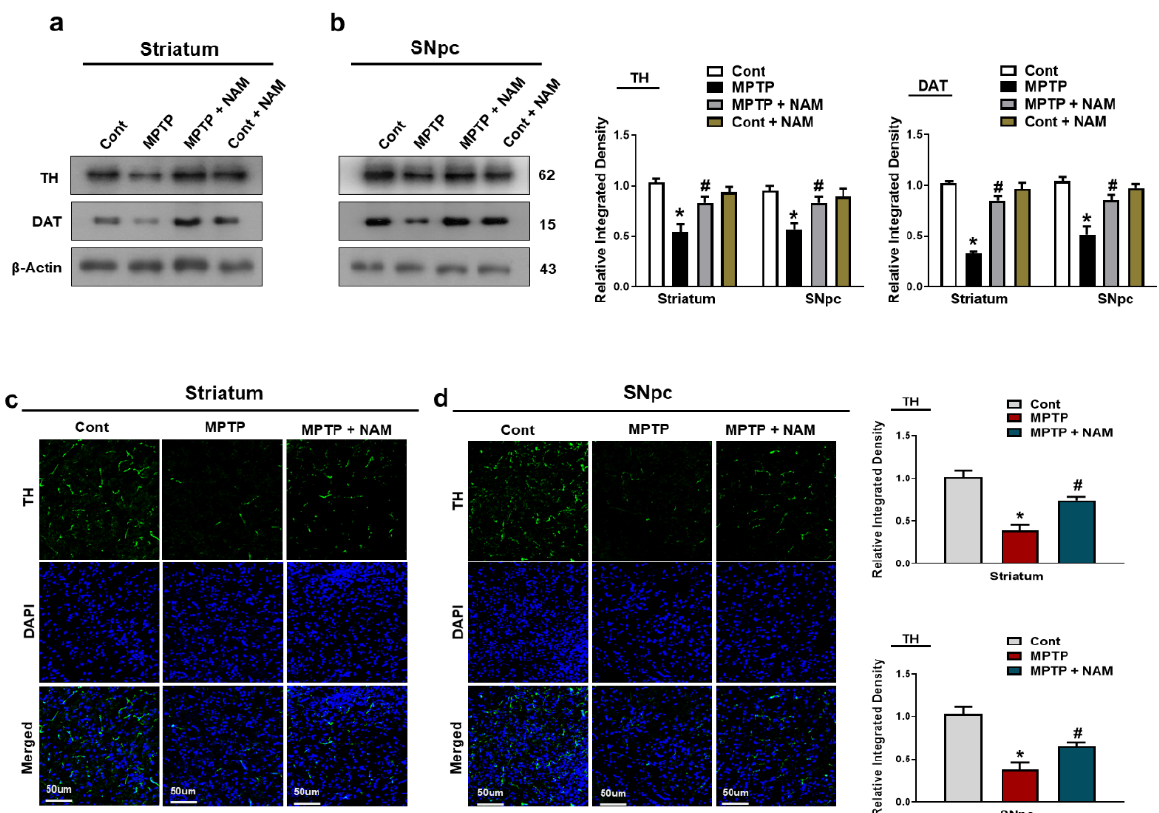
Figure 4. Nicotinamide (NAM) upregulated the TH and DAT level in the striatum and SNpc of the mouse brain. ( a , b ) Images of the scanned Western blot results and their representative histograms showing expression of TH and DAT. β -actin was used as a loading control; ( c , d ) Immunofluorescence analysis of TH, (green) and its corresponding histogram and dapi staining (blue) in the striatum and SNpc regions. The densities values are expressed in arbitrary units (AU), magnification 10 × , scale bar = 50 µ m. The values are expressed as the mean ± SD for indicated proteins ( n = 10 mice/group), and the number of independent experiments was n = 3. * Significantly different from the control group, # Significantly different from the MPTP-treated group. Significance: * p < 0.05; # p < 0.05.